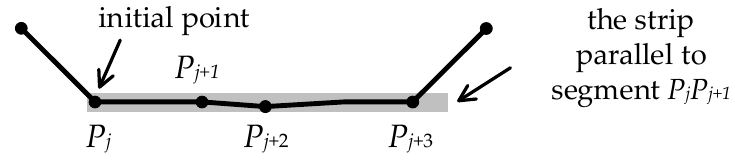
Figure 9. Extraction of a long, straight and flat road section.